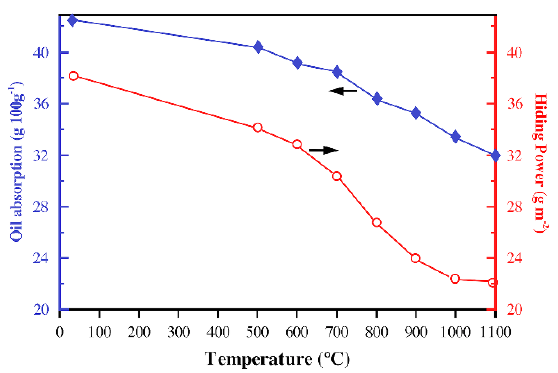
Figure 5. Oil absorption (rhombus) and hiding power (hollow circle) of CaCO 3 ‐ TiO 2 nH 2 O calcined at different temperatures.